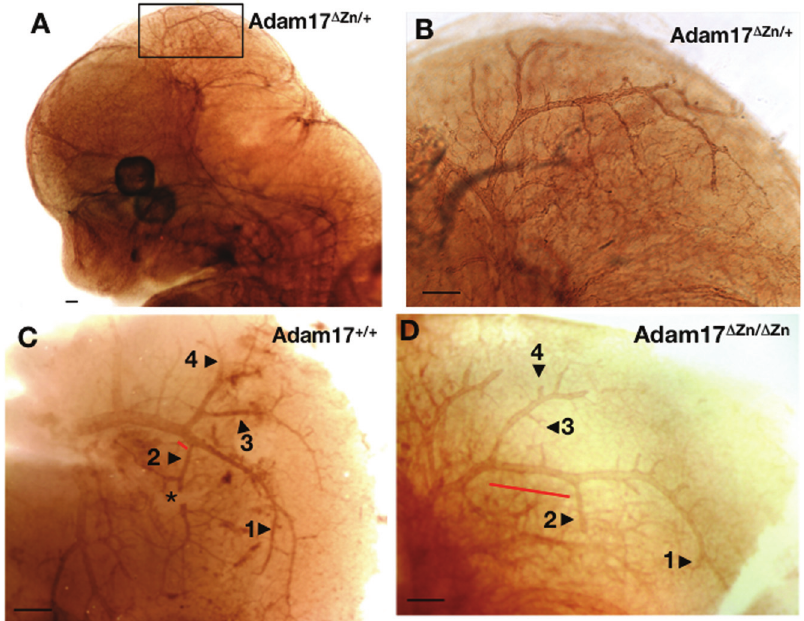
Figure 3. Adam17 D Zn/ D Zn vascular phenotype. Whole-mount E14.5 embryos were stained with CD31 (PECAM) antibodies to characterize their vascular morphology. Panel A shows the vasculature of an intact heterozygous embryo. Boxed area indicates the location of the region shown at higher magnification in panel B after dissection to allow flat mounting to view the cranial vessels. Similar views from heads of wild-type (C) and mutant (D) embryos. Wild-type patterning of the branches is severely disrupted in Adam17 D Zn/ D Zn embryonic heads. Vessels numbered 1–4 are stunted and less branched in the mutant embryos. Although the distance between vessel 2 and the branch leading up to vessels 3 and 4 seems increased in the mutant head shown (red bar), this distance was variable in wild-type heads. The asterisk marks a vessel damaged during dissection. Scale bars are 200 m m.